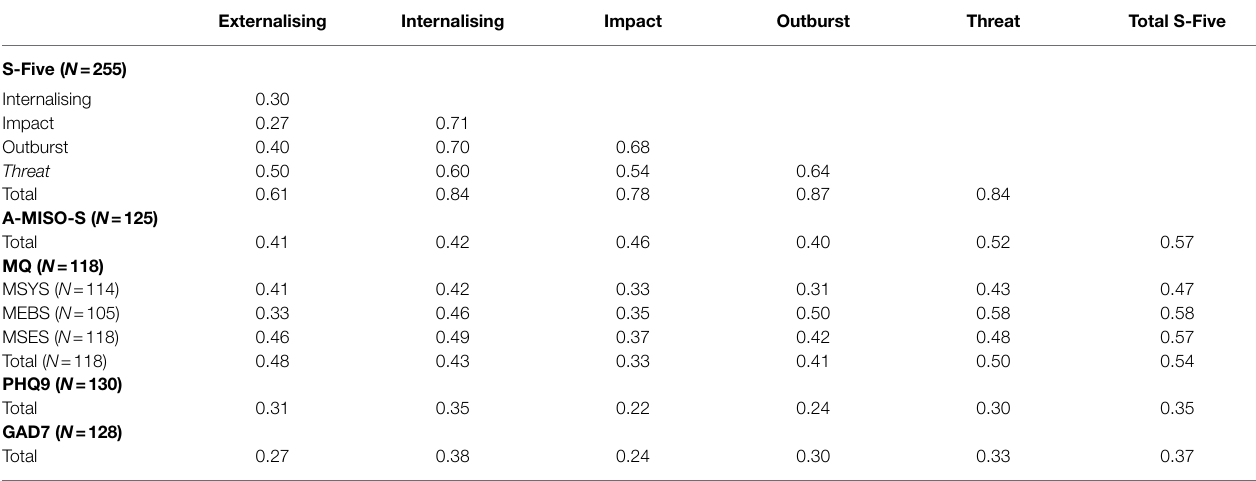
TABLE 3 | Intercorrelations of the S-Five scores, and correlations with other measures (validity assessment).